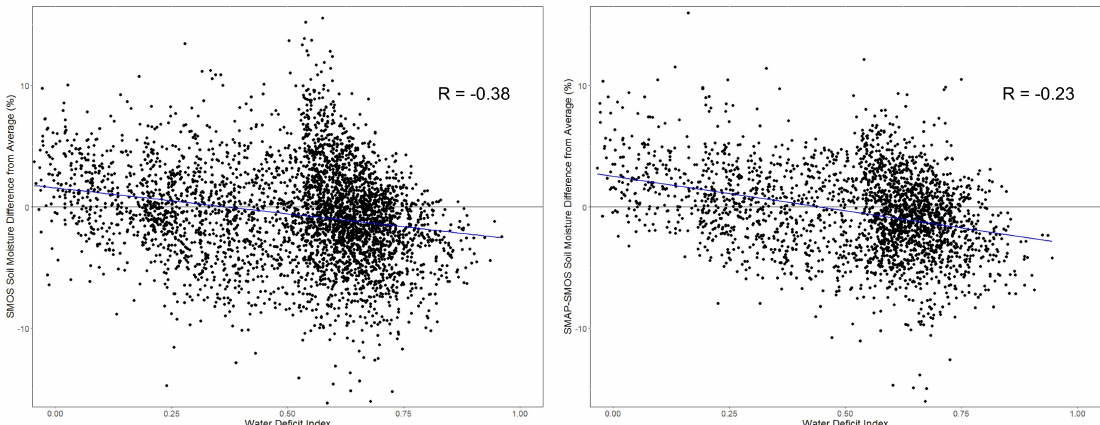
Figure 7. Comparison of WDI modelled from station data to SMDA from blended SMAP-SMOS time series. Trend line represents a linear correlation of − 0.38 for the SMAP-SMOS SMDA and − 0.23 for the SMOS-only SMDA, significant at p < 0.001.